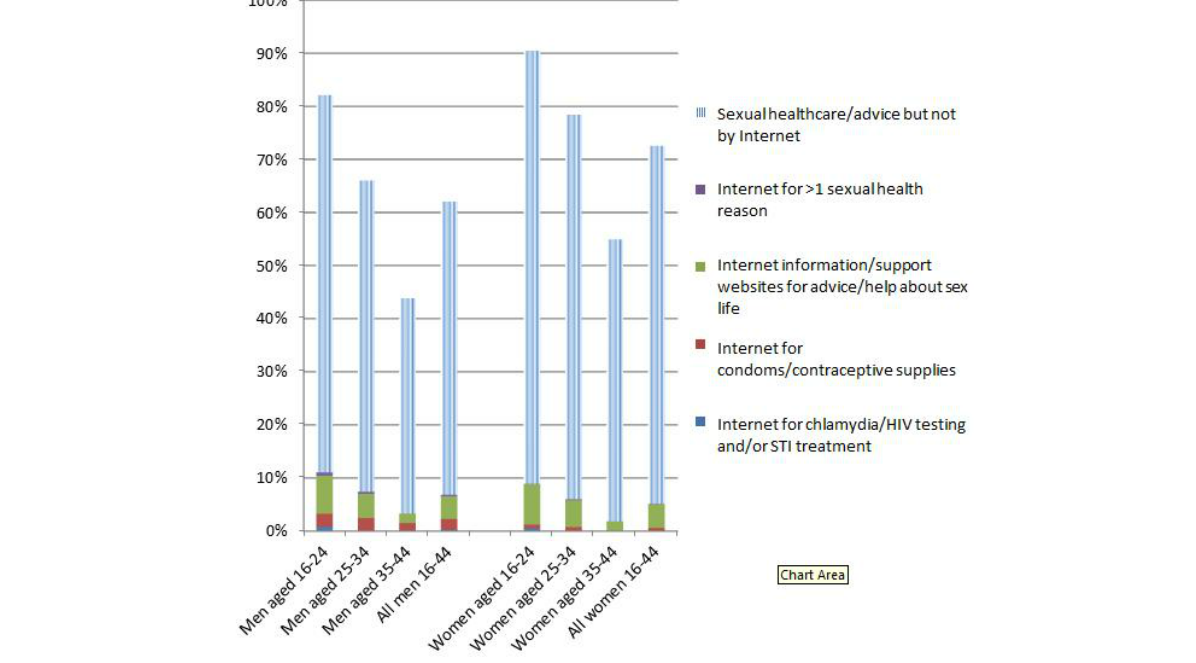
Number eligible for